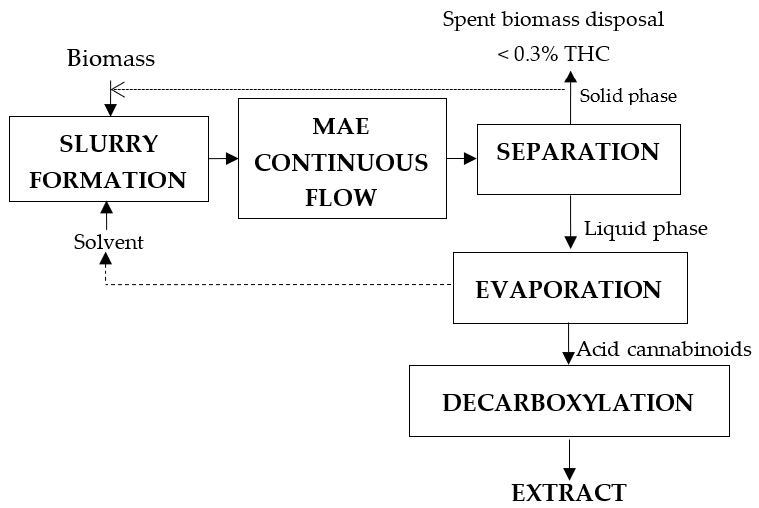
Figure 4. Schematic of the MAP TM cannabis extraction & acidic cannabinoids decarboxylation.